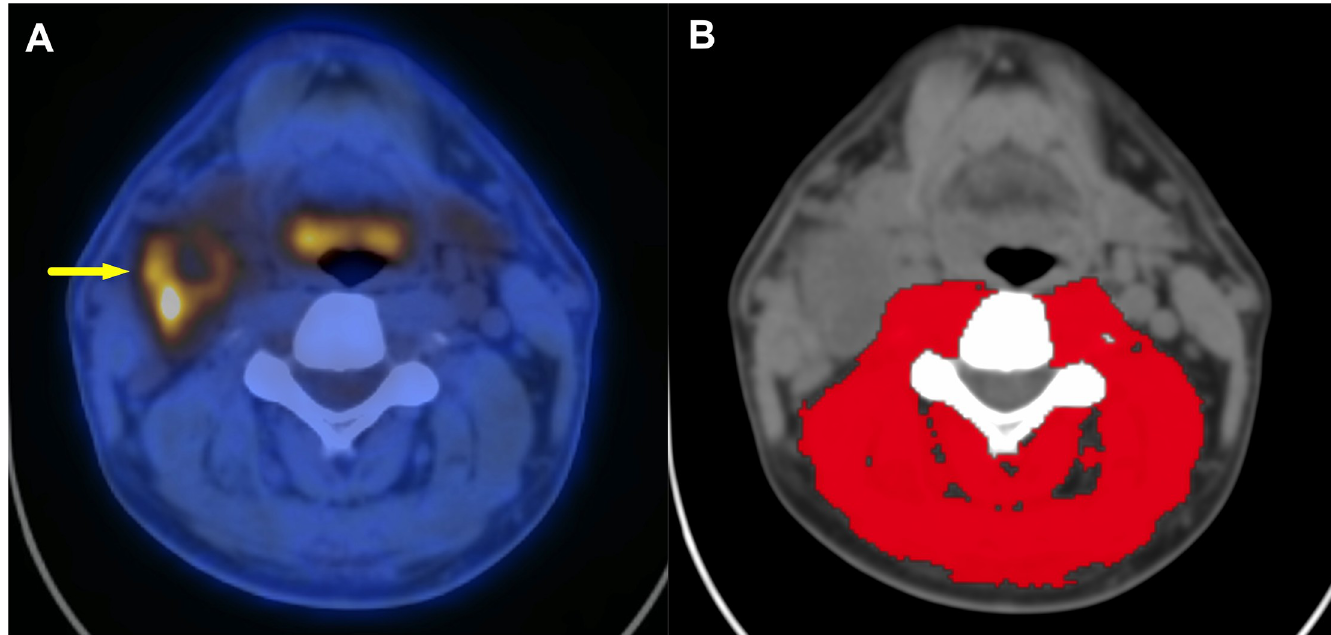
Fig 1. Representative fusion PET/CT (A) and CT (B) images used to measure the paravertebral muscle area at C3. A 57-year-old male patient with right tonsillar cancer. Metastatic lymphadenopathy is detected at right cervical levels II–III with invasion of the right sternocleidomastoid muscle.